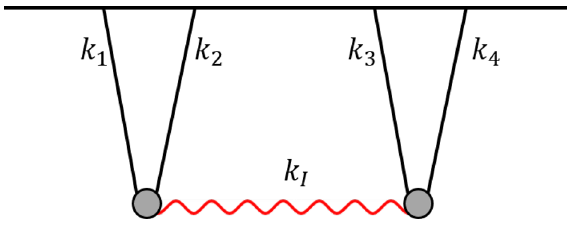
Figure 11 . Example 3: massive vector exchange with chemical